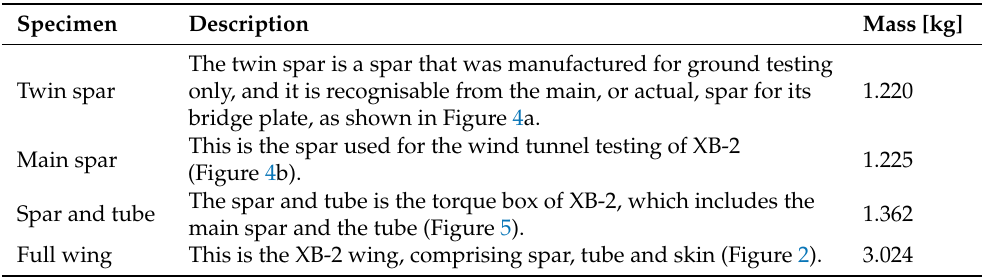
Table 6. Specimens of the testing campaign.